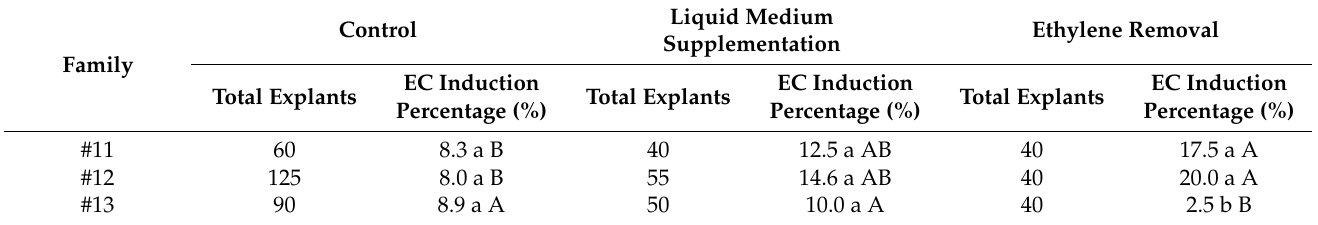
Table 5. Effects of ethylene removal and liquid medium supplementation on EC induction percentage of Korean pine.